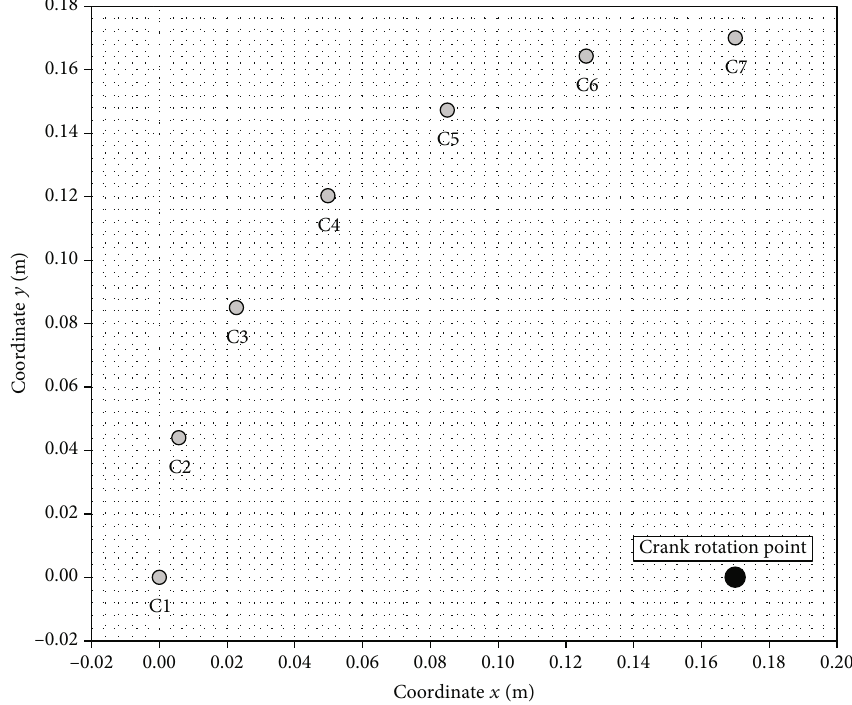
Figure 9: The measuring points for the crankset (phases C I and C